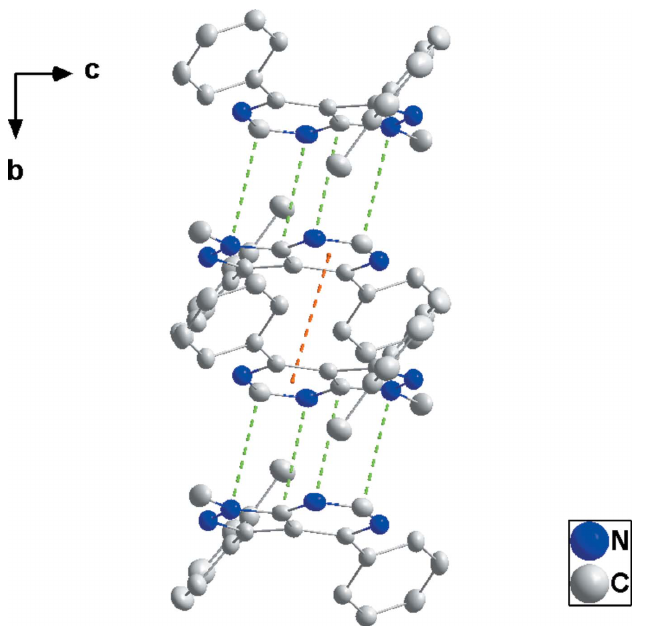
Figure 2 Detail of the (cid:2) -stacking (orange dashed line) and the offset (cid:2) -stacking (green dashed lines) viewed along the a -axis direction. H atoms have been omitted for